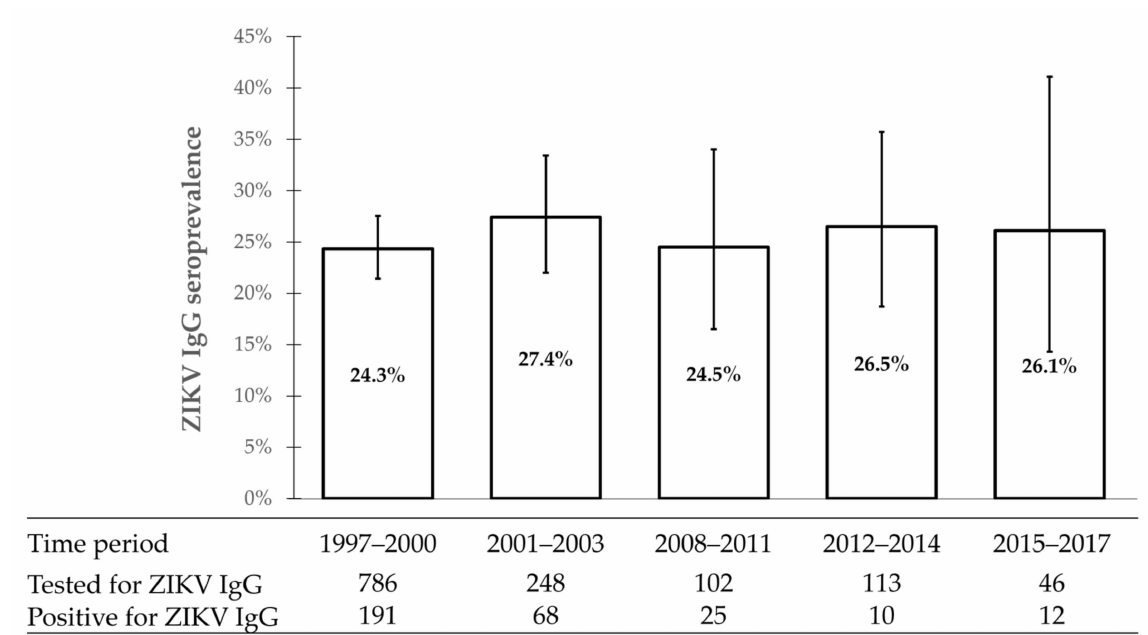
Figure 3. Evolution of ZIKV IgG seroprevalence among pregnant women in Thailand during 1997– 2017. The whisker error bars represent the 95% confidence intervals.